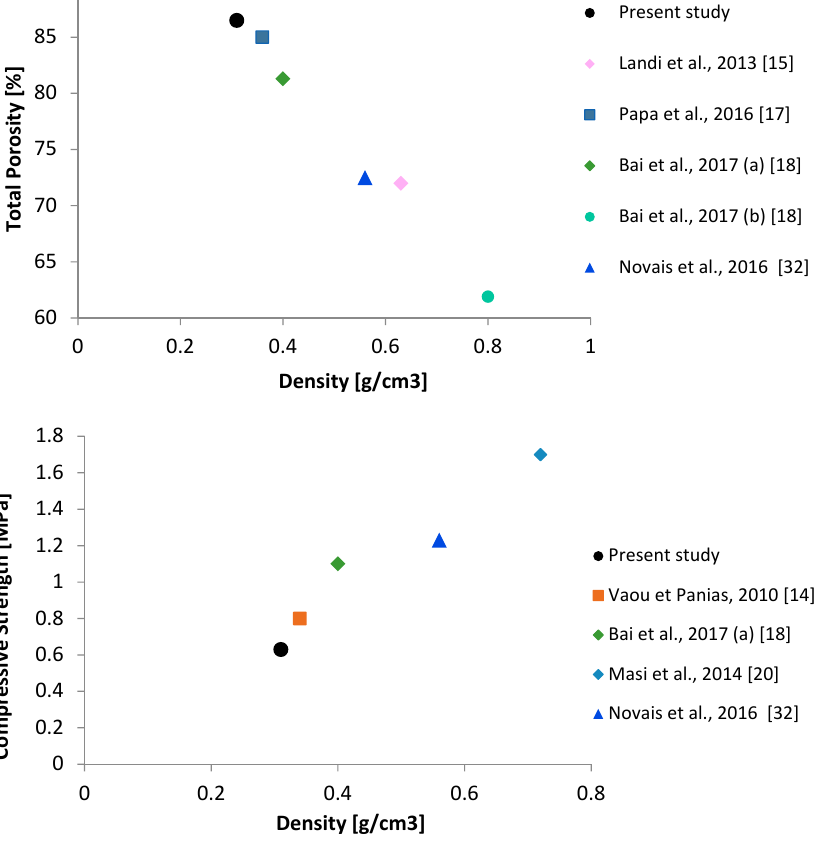
Figure 6. Total porosity/Density (upper panel) and Compressive strength/Density (lower panel) relationship for geopolymers from different literature studies.